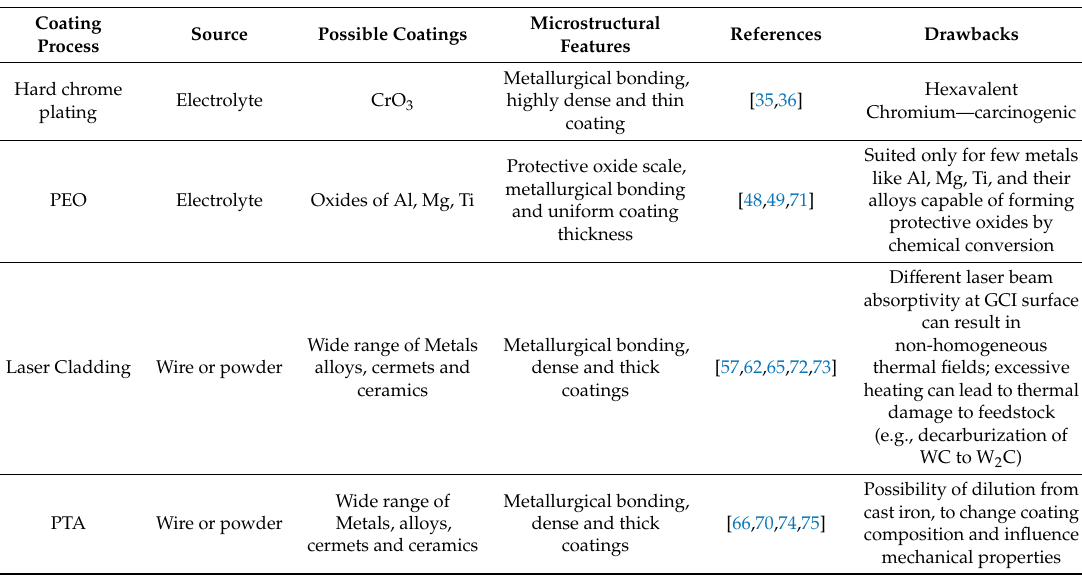
Table 2. Summary of non-thermal spray processes as candidates for brake disc coating applications.